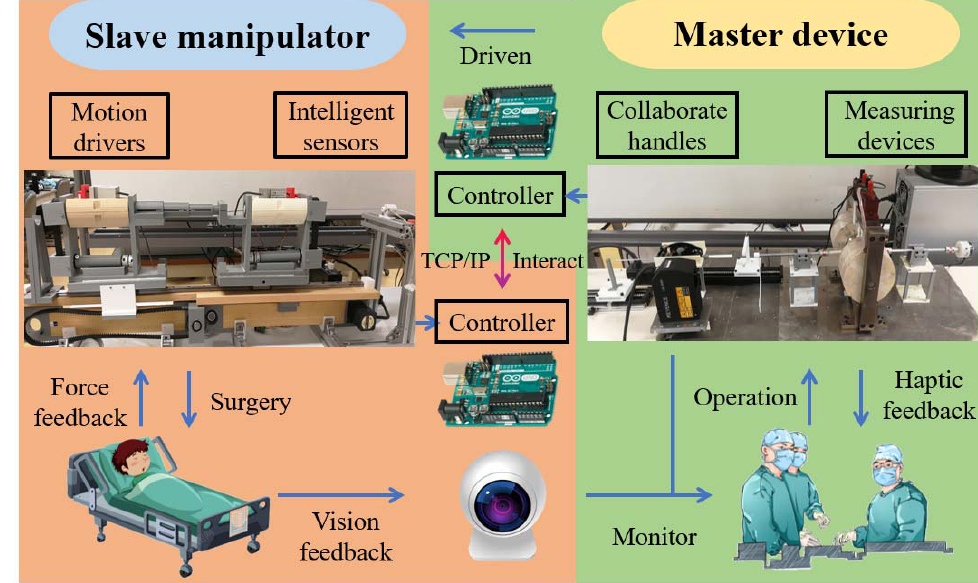
Figure 4. The control architecture diagram of the developed ECRS.